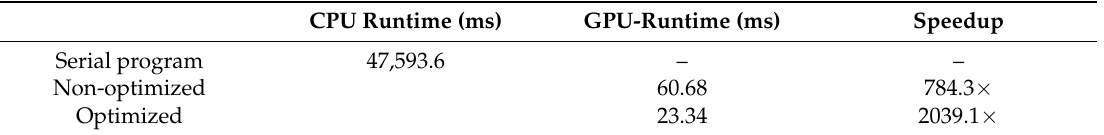
Figure 13. Runtime for the GPU ‐ based SDCSM program with and without asynchronous data transfer (ADT) optimization. Table 5. Runtime and speedup for the GPU ‐ based SDCSM program with asynchronous data transfer (ADT) optimization.